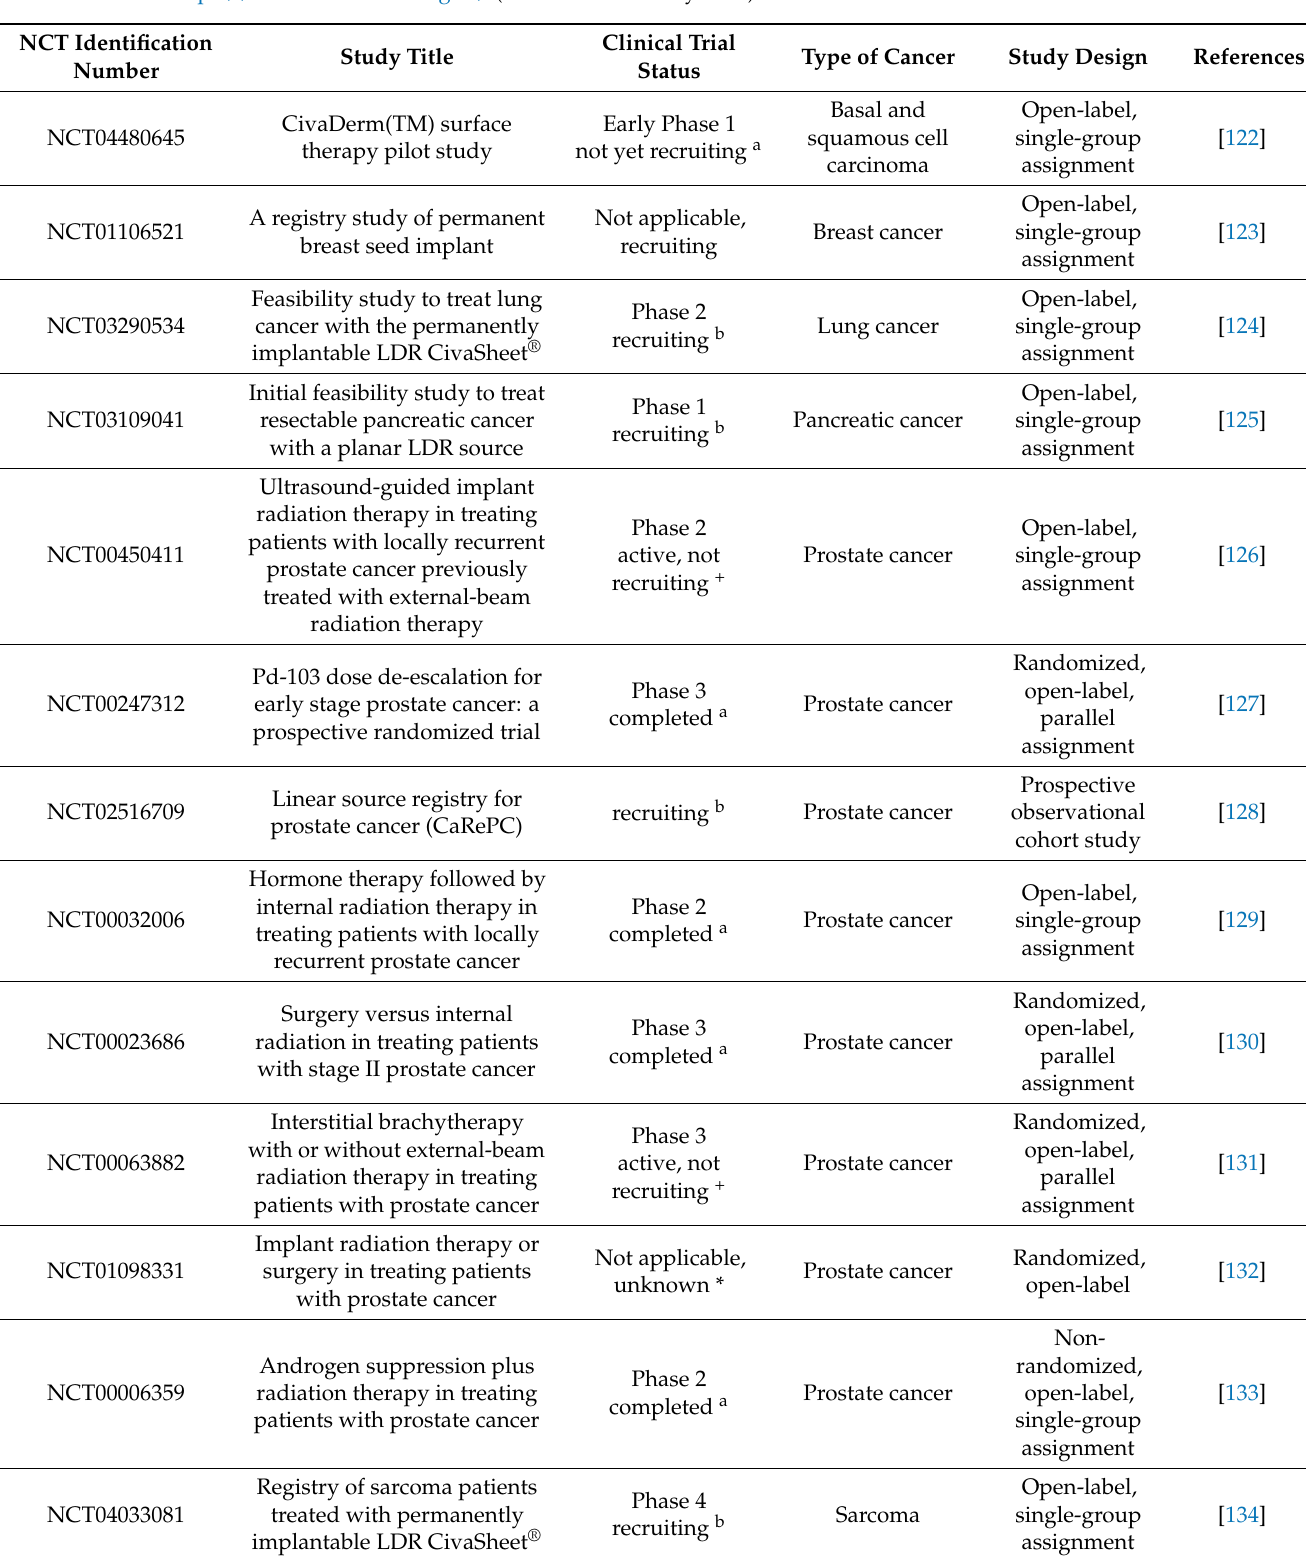
Table 2. Recent and current clinical trials on palladium-based therapy. This table was compiled from the information available at https://www.clinicaltrials.gov/ (accessed on 25 May